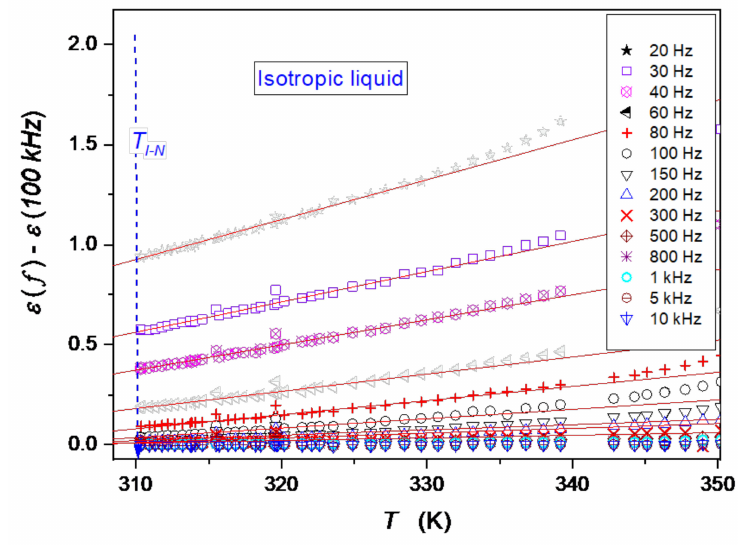
Figure 3. The experimental temperature dependence of the low-frequency, ionic–related, behavior of the real part of dielectric permittivity in the isotropic phase of 5CB. As the ‘non-ionic’ reference dielectric constant for the frequency f = 100 kHz was assumed